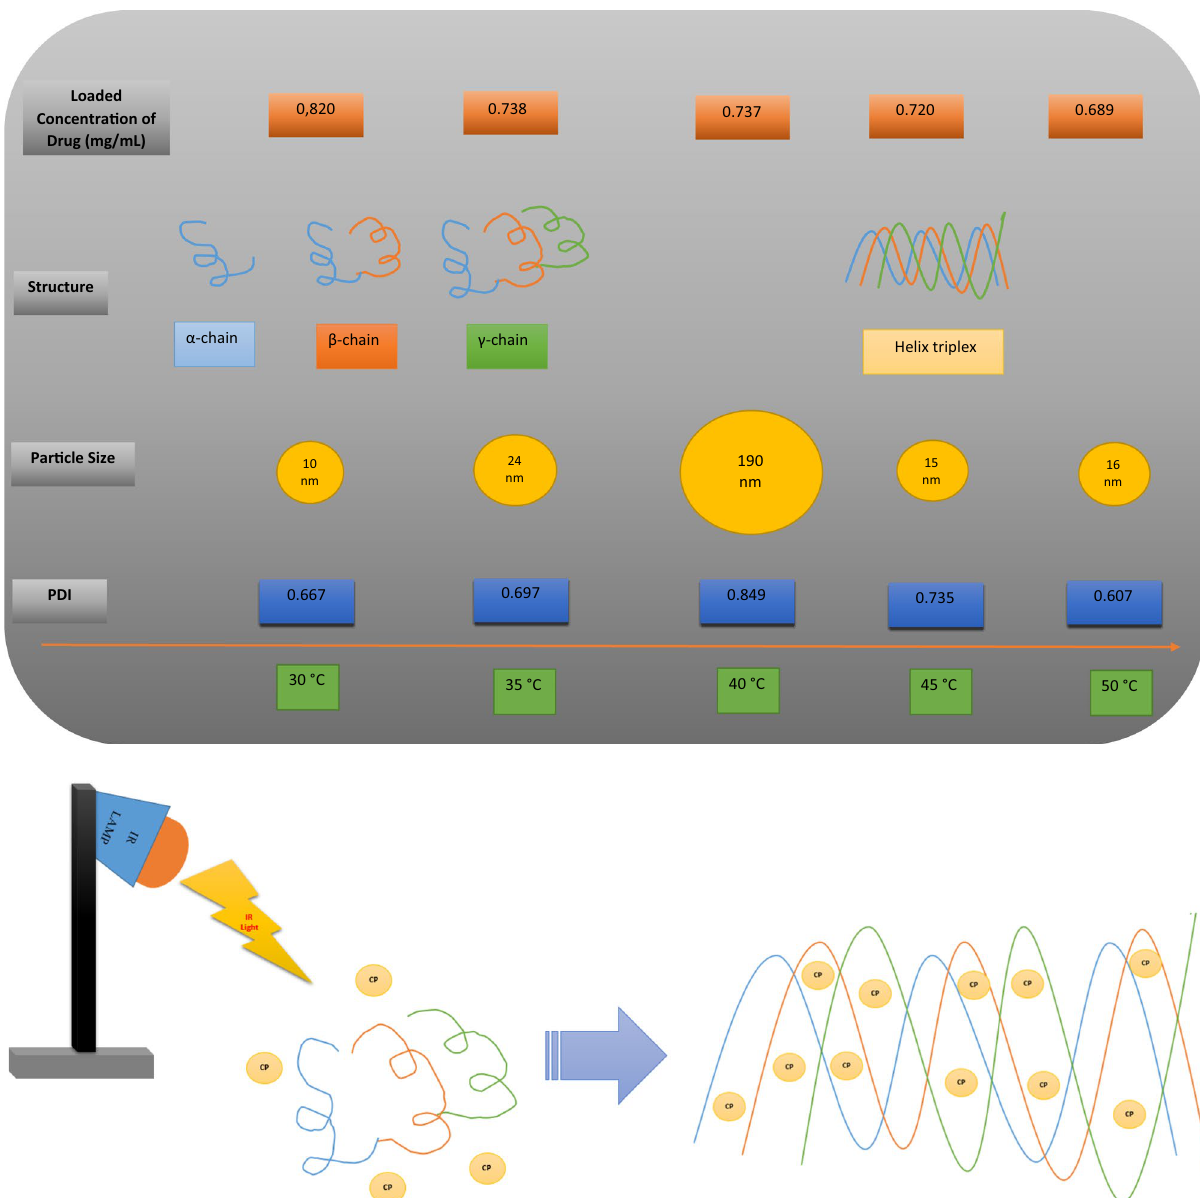
Figure 2. Comparative schema of structure, particle size, PDI value and loaded concentration of different gelatin-based CP-NPs exposed to IR light at different temperatures (30, 35, 40, 45, 50